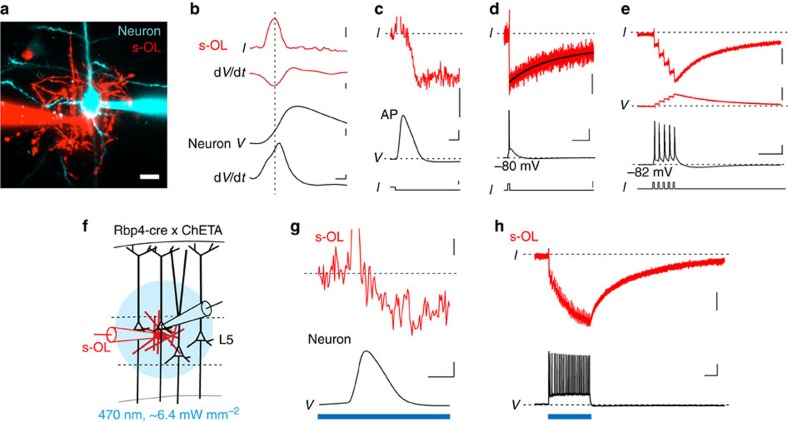
Action potentials evoke time-locked inward currents in s-OLs.(a) Confocal z-projected image of dual-whole-cell recording from L5 neuron–s-OL pair in the somatosensory neocortex. Scale bar, 20 μm. (b) The dV/dt of the AP aligns with the fast current transient in the s-OL, reflecting the capacitive charge of the s-OL membrane during the rising phase of the AP. In current clamp, the s-OL membrane voltage change is slow (dV/dt) compared with the neuronal AP. Note the dV/dt is from a different recording and filtered for display. The other traces are from the same cell as in c and d. Scale bars, (top to bottom) 10 pA, 1 V s−1, 30 mV (middle), 100 V s−1 and 0.1 ms. (c) AP repolarization temporally aligns with a rapid inward current in the s-OL. Average of 35 trials; scale bars, 5 pA, 30 mV, 500 μs and 0.7 nA. Capacitive current transient clipped for clarity. (d) The single AP evoked a rapid inward current in the s-OL (red trace, top) that decayed slowly (held at –91 mV; black fit, τ1=78 ms, τ2=451 ms). Traces displayed are the average of 25 trials. Scale bars, 2 pA, 30 mV, 50 ms and 1 nA. (e) Five APs evoked at 100 Hz potentiated the inward current amplitude in the s-OL (clamped to –88 mV, upper red trace). In current clamp (lower trace), the s-OL was depolarized by ∼500 μV. Traces are average of 26 trials. Scale bars, 10 pA, 500 μV, 30 mV and 50 ms, respectively. (f) Illustration of the targeted activation of layer 5 neurons by ChR2 while simultaneously recording from s-OL–neuron pairs. (g) Single light-evoked neuronal AP led to a capacitive transient (clipped) in the s-OL, followed by an inward current that activated during AP repolarization similar to electrical evoked AP. Scale bars, 2 pA, 30 mV and 0.5 ms. (h) The synchronised network activation of layer 5 neurons by ChR2 led to a large AP evoked inward current in a simultaneous recorded single s-OL. Scale bars, 20 pA (top), and 30 mV and 0.2 s (bottom).